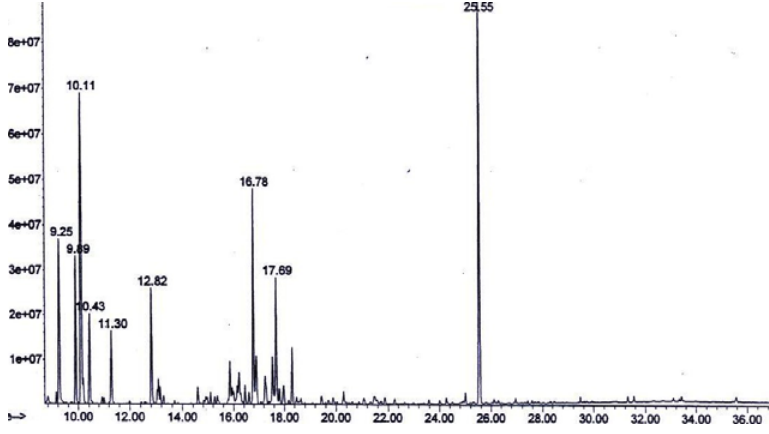
FIGURE 4 . Total ion chromatogram of air sample collected by an activated carbon